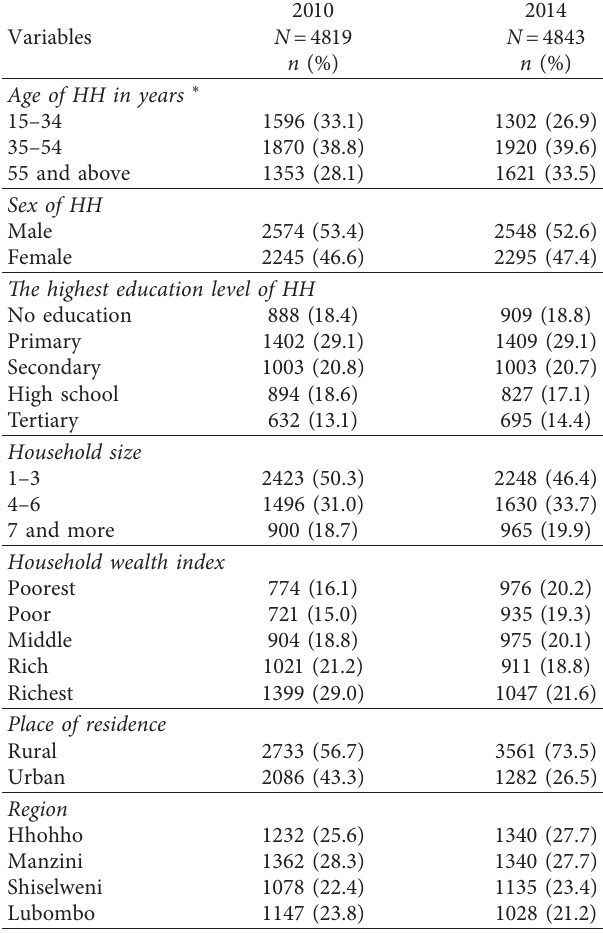
Table 1: Distribution of the study samples (unweighted) by survey